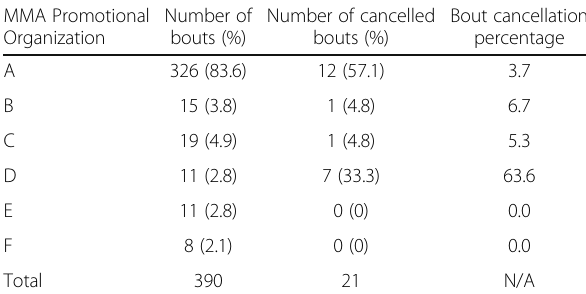
Table 2 Number of cancelled bouts and cancellation rate for MMA promotional organizations in Calgary, Alberta